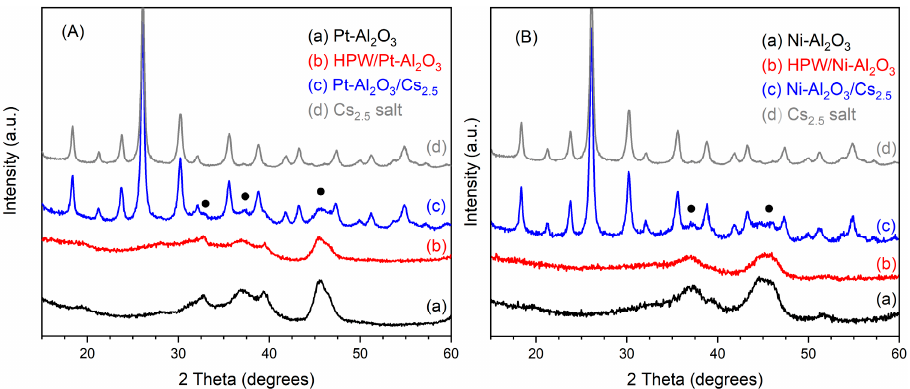
Figure 1. Powder X-ray diffractograms of ( A ) Pt-Al 2 O 3 catalysts series and ( B ) Ni-Al 2 O 3 catalysts series together with diffractogram of Cs 2.5 salt for comparison. Closed circles correspond to the main peaks of γ -alumina phase (COD 1101168).